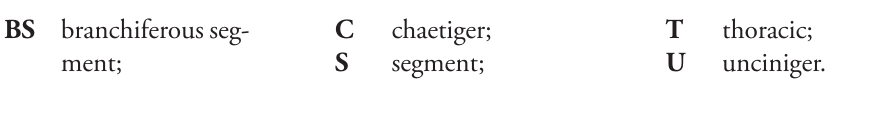
C chaetiger; S segment;